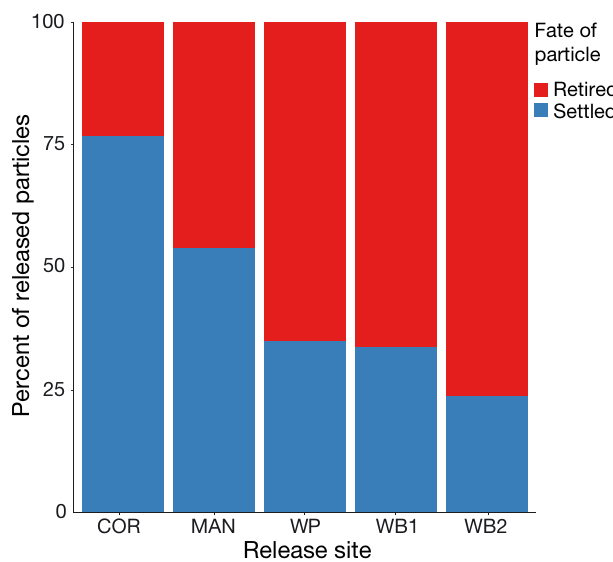
Fig. 5. Percent of Perna canaliculus particles released from each site which encounter suitable settlement habitat (de- fined as the seafloor or coast) during the settlement compe- tency window 3−5 wk after release. Retired: the particle did not encounter suitable settlement substrate within the set- tlement competency window and was therefore removed from the